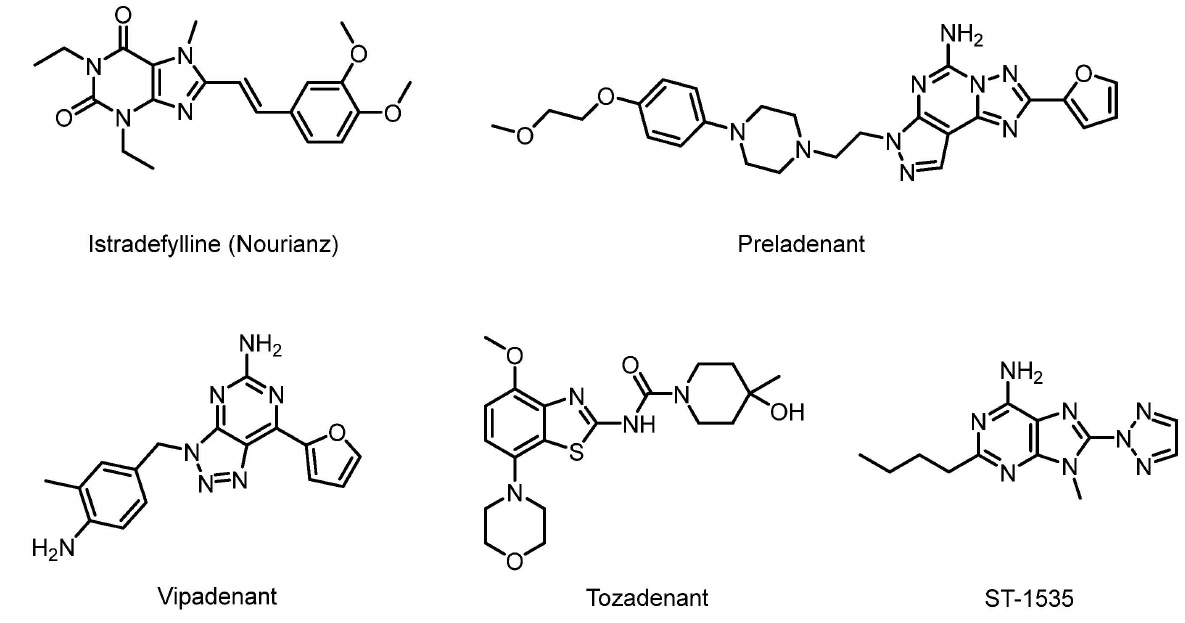
Figure 1. A 2A receptor antagonists as anti-Parkinson’s disease